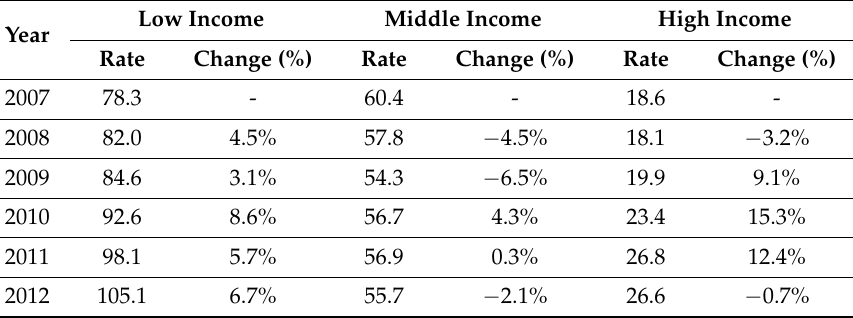
Monthly alcohol-attributed incident rates of hospitalization (per 100,000 persons) working-aged